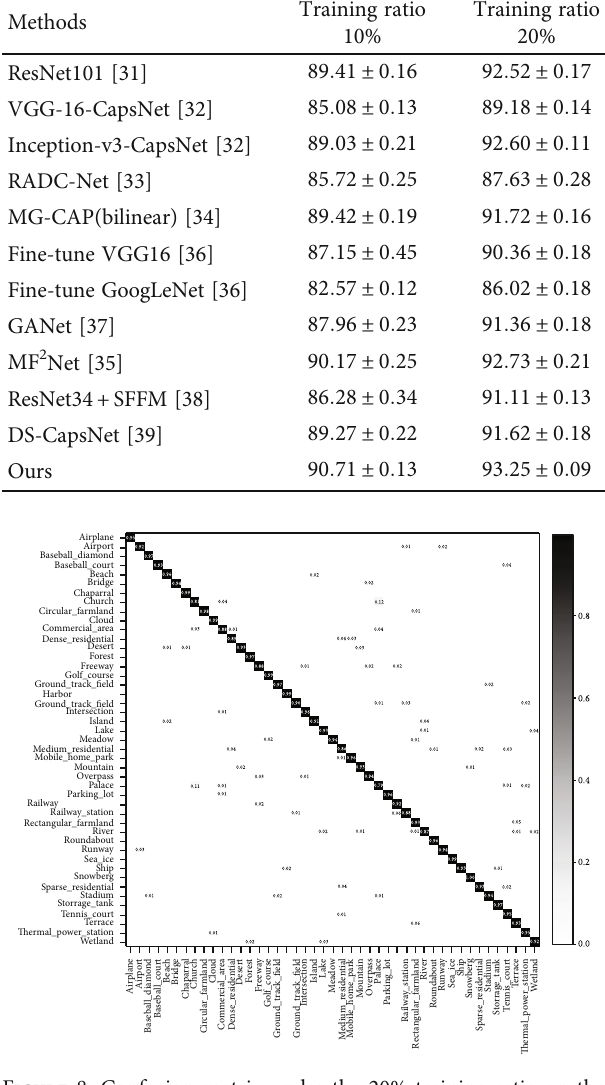
Figure 8: Confusion matrix under the 20% training ratio on the NWPU-RESISC45 data